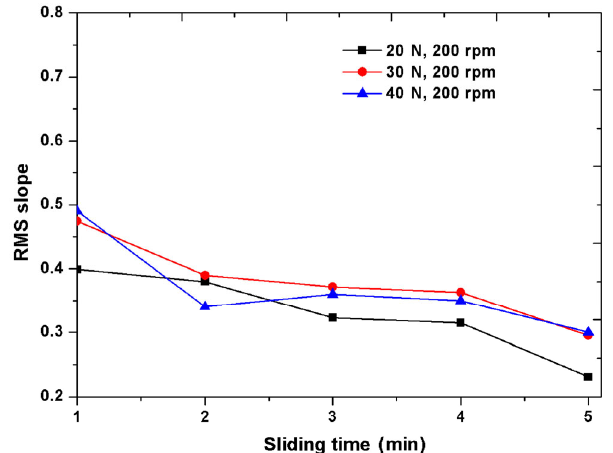
Fig. 16 Variation of S dq with sliding time for the same speed and different loads.